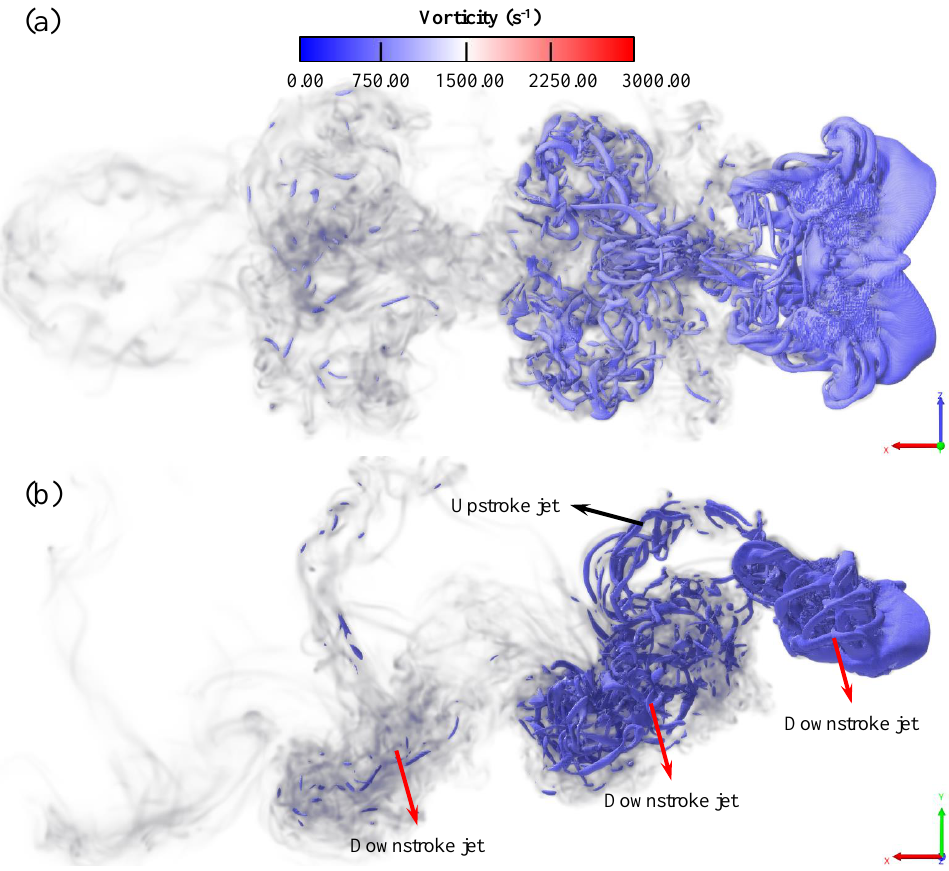
(d) Figure 13. Vortical structures visualized by the vorticity. The iso-surface of ω = 6 × 10 2 s − 1 is drawn: